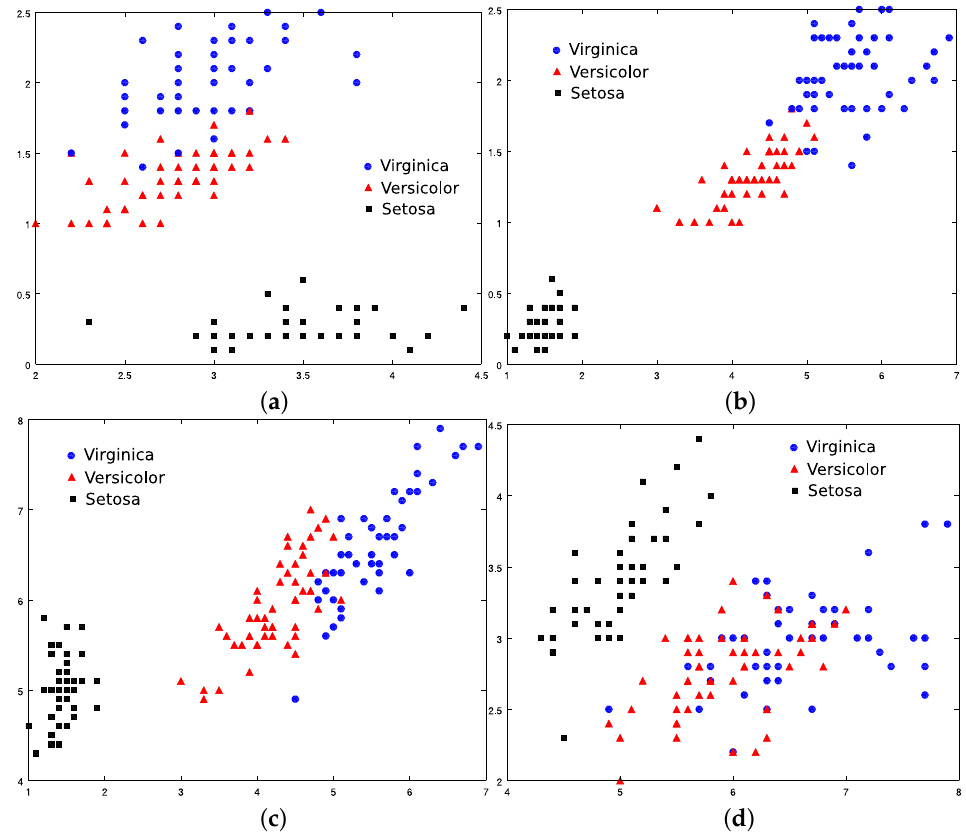
Figure 3. 2D projections of Iris data using a set of 3 features in different order each time ( a ) Features 2, 1 and 4 ( b ) Features 3, 2 and 4 ( c ) Features 3, 4 and 1 ( d ) Features 1, 3 and 2.